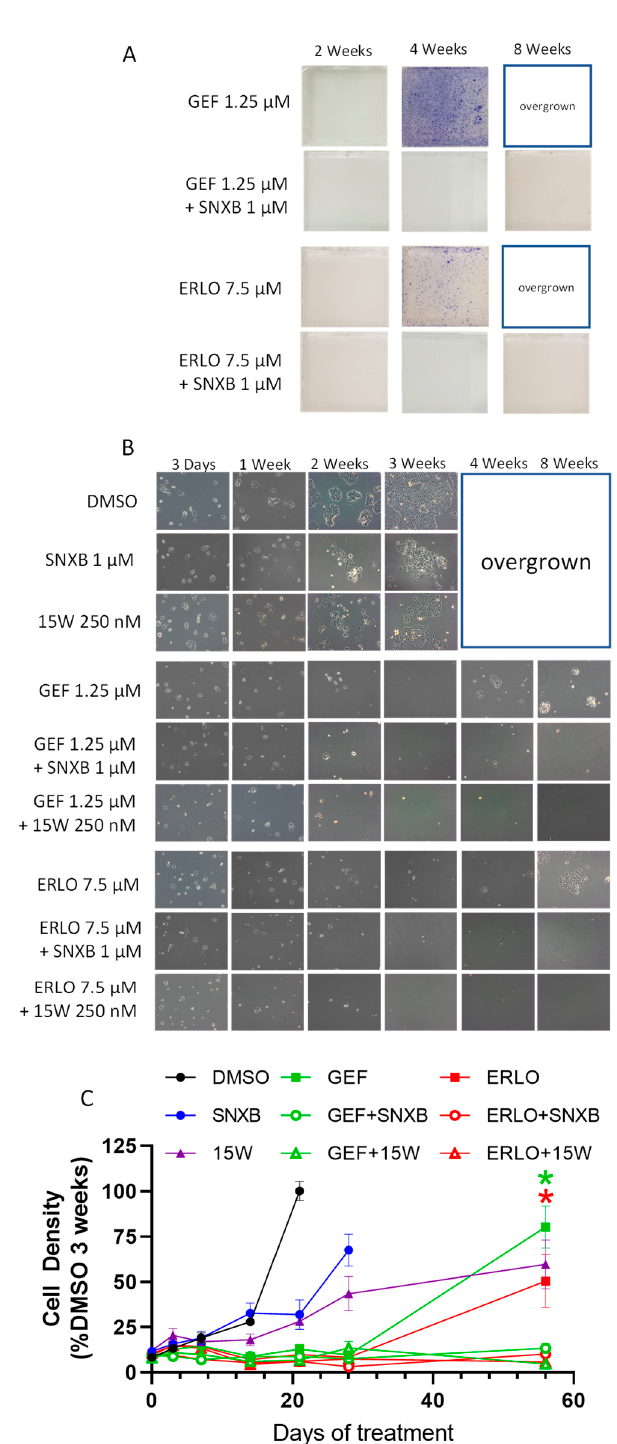
Figure 1. CDK8/19 inhibitors senexin B (SNXB) and 15w prevent resistance to EGFR inhibitors gefitinib (GEF) and erlotinib (ERLO) in BT474 breast cancer cells. ( A ). Representative photographs of crystal violet-stained flasks at 2, 4, and 8 weeks of treatment. ( B ). Representative phase-contrast microphotographs at 3 days, and at 1, 2, 3, 4 and 8 weeks of treatment. ( C ). Densitometric measurements of microphotographs expressed as percentage of cell density in DMSO controls at 3 weeks. Data shown as mean ( n = 4 images/flask) ± SEM. p < 0.0001 for GEF vs. GEF+SNXB/15w ( * ) and ERLO vs. ERLO+SNXB/15w ( * ) at 8 weeks.